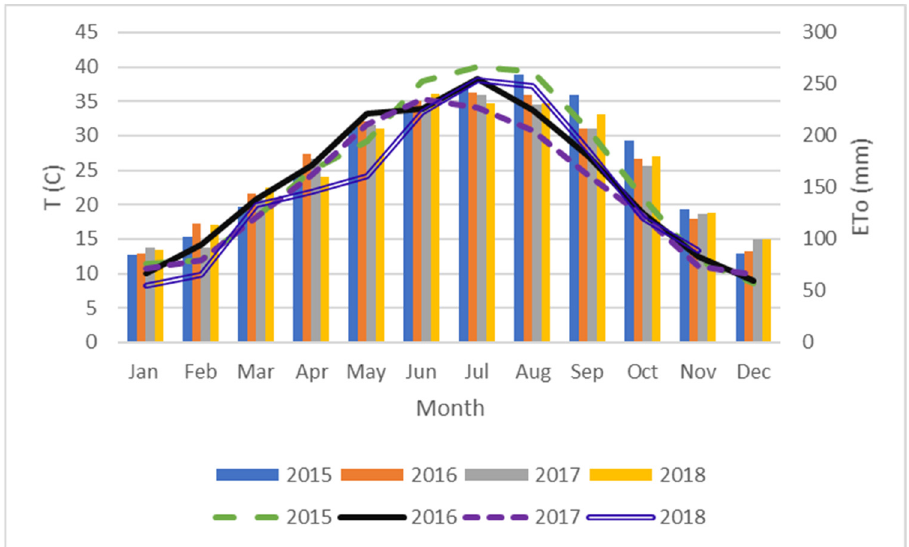
Figure 2. Average monthly reference evapotranspiration (ET o ) in the study area (represented by bars) compared with the average monthly temperature (represented by lines and dash lines) between 2015 and 2018.